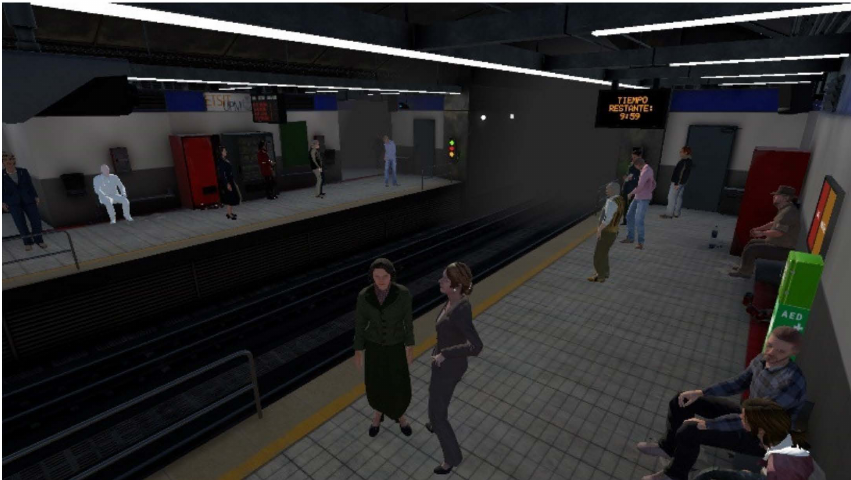
Figure 1. Scene composition based on the Metro of Madrid with assets created and animated in Blender and with static physics collisions baked into the